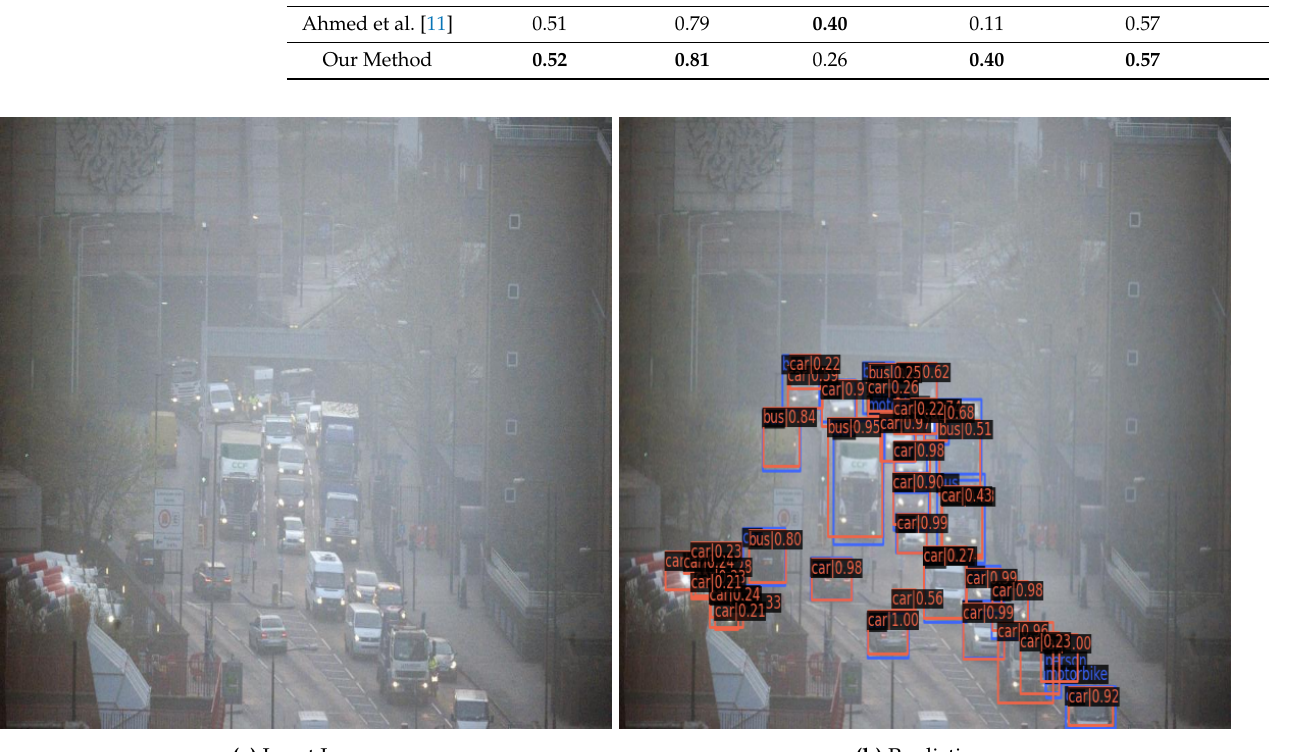
Figure 8. Example of results achieved on the RESIDE Dataset. Figure 8a represents an input image, whereas Figure 8b is the final output with the detected object. The blue color represents ground truth annotation, and orange is the network prediction. Table 3. Comparison between the proposed method and previous state-of-the-art results on the CURE-TSD dataset. AP s denotes average precision for small area, whereas AP m represents average precision for medium area and AP l depicts average precision for large area. The IoU threshold is also defined in the table. Best results are highlighted.